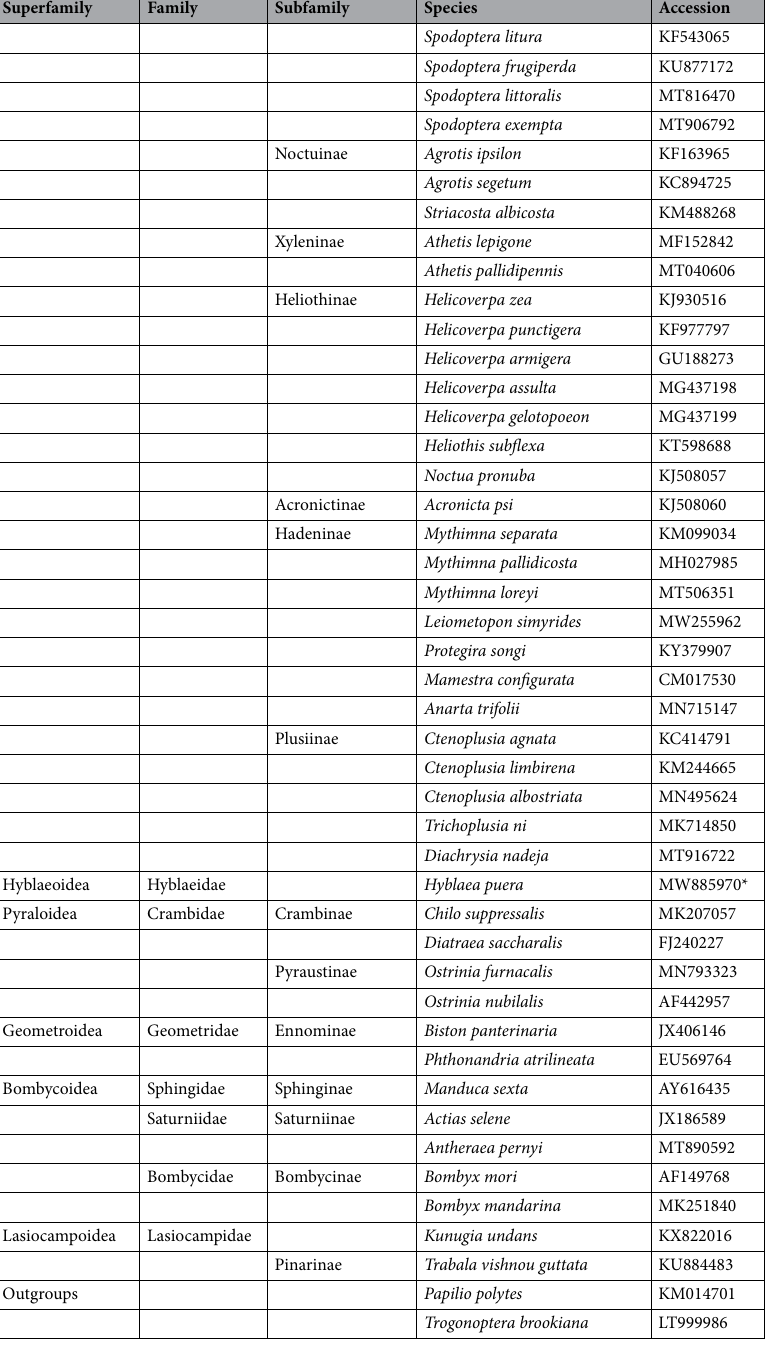
Table 1. List of the complete mitogenome of the superfamily Noctuoidea reported so far. * indicates the species that are used in this